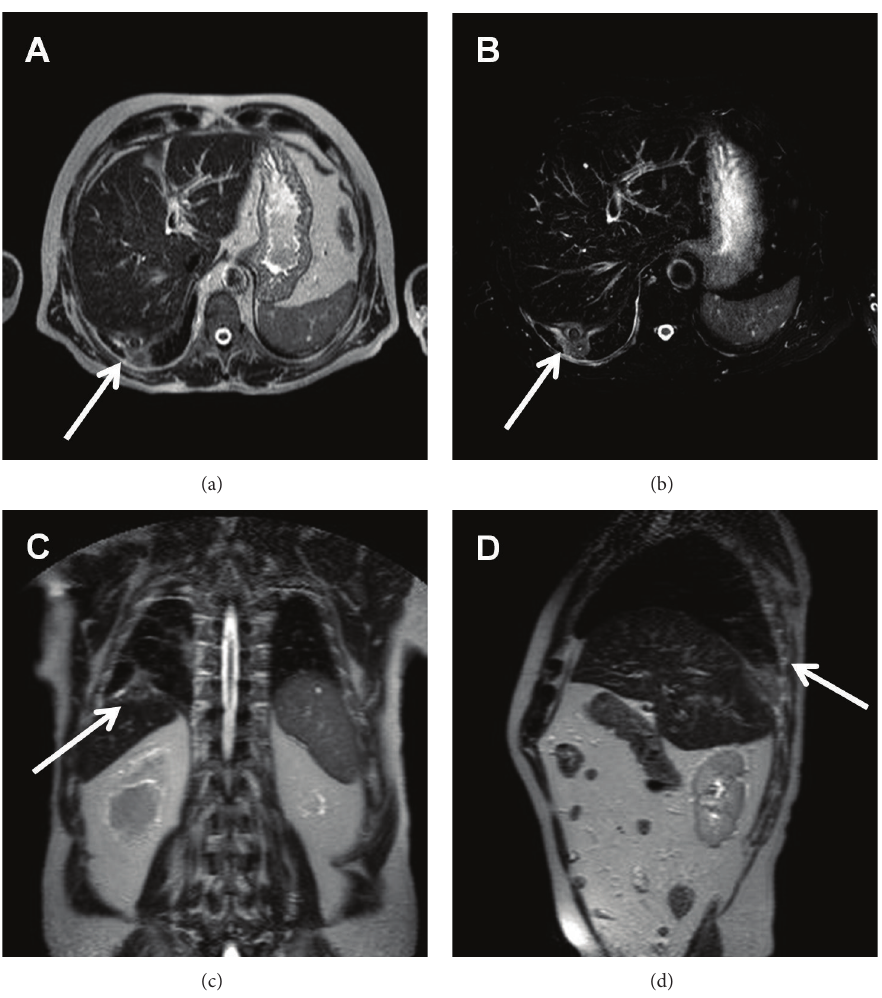
Figure 3: Axial (a and b), coronal (c) and sagittal (d) images from an abdomen magnetic resonance showing a lesion with solid component surrounded by a blood-like fluid labrum, with compression of the underlying liver parenchyma, pulmonary consolidation and minimal pleural effusion ( arrows